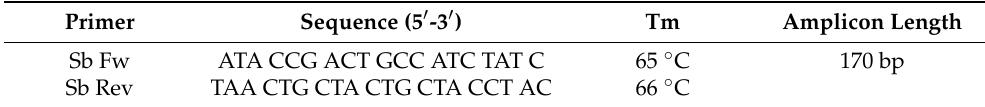
Table 1. Details of primers and amplicons used in this work. Primer Sequence (5 (cid:48) -3 (cid:48)